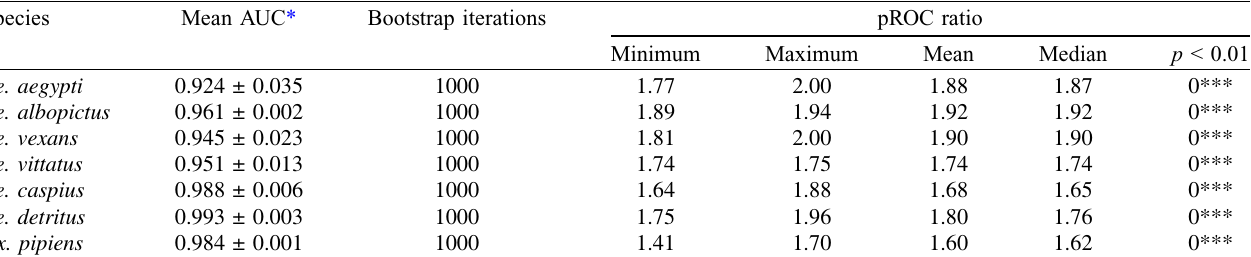
Table 4. Area under the curve (AUC) values and partial receiver operating characteristic (pROC) ratios summarizing the performance of ecological niche models (average over 20 runs).